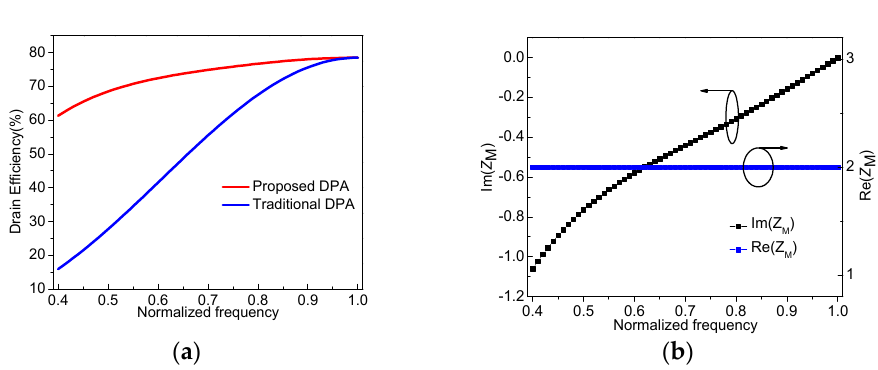
Figure 6. Drain efficiency and impedance versus the normalized frequency: ( a ) drain efficiency versus the normalized frequency; ( b ) impedance Z M versus the normalized frequency.